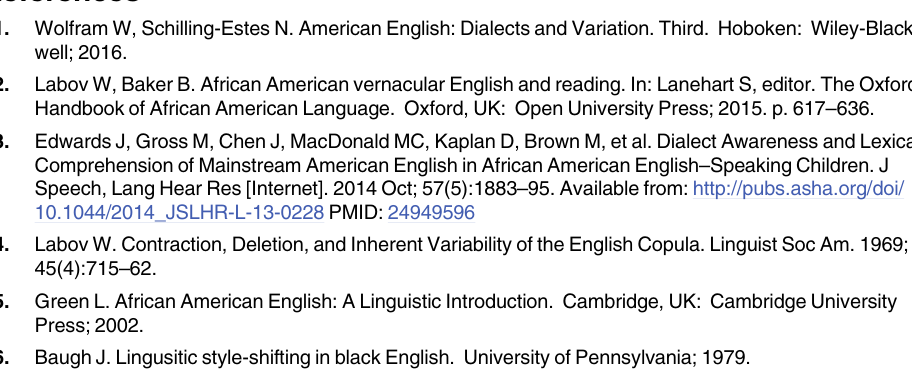
S3 Fig. Results of 2 x 2 x 3 x 2 Global ANOVA for the two selected time windows (200–400 ms and 400–900 ms) with interaction